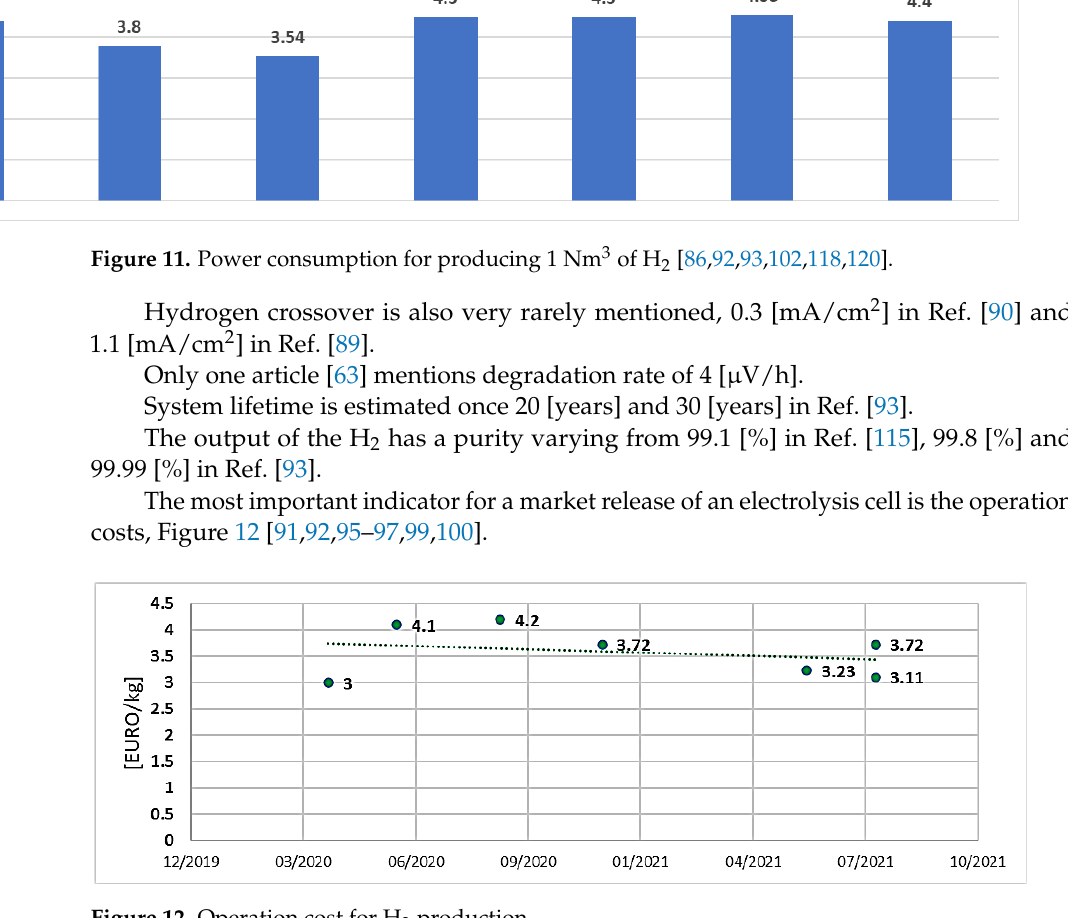
Figure 11. Power consumption for producing 1 Nm 3 of H 2 .[86,92,93,102,118,120] The H 2 production indicator varies from 3.09 [Nm 3 /h] with an electrolysis system size